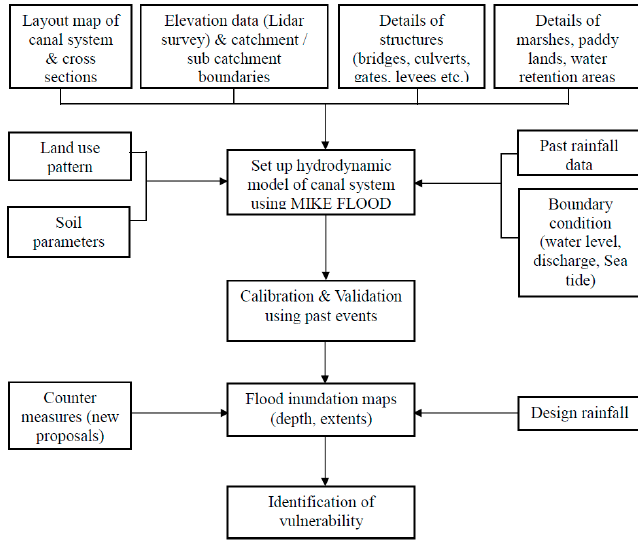
Figure 7. Methodology of the study.